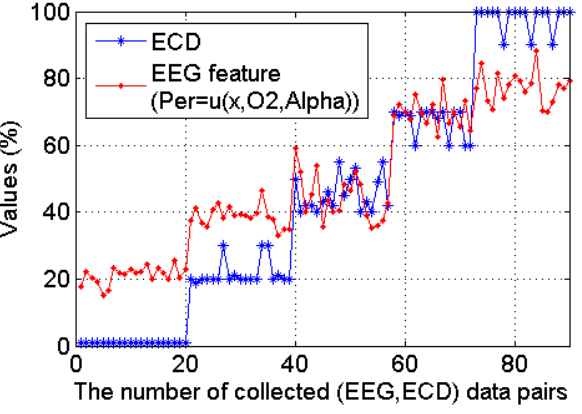
Figure 10. The linear relationship between ECD and a representative EEG feature which were collected from 20 subjects from a real-life experiment environment (monotonous driving experiment).